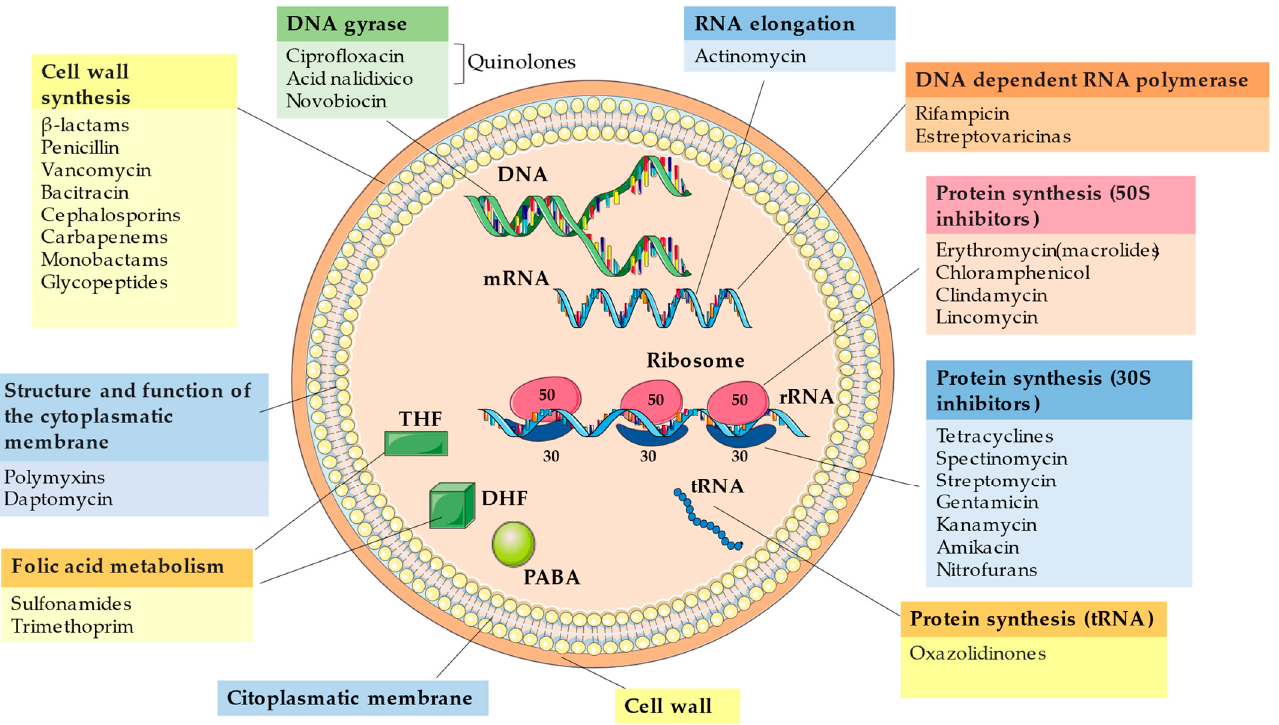
Figure 1. Mechanisms of action antimicrobial. The authors (2022) adapted from [42]. PABA = para-aminobenzoic acid; DHF = dihydrofolate; THF = tetrahydrofolate; DNA = deoxyribonucleic acid; mRNA = messenger ribonucleic acid; tRNA = transporter ribonucleic acid; rRNA = ribosomal ribonucleic acid.